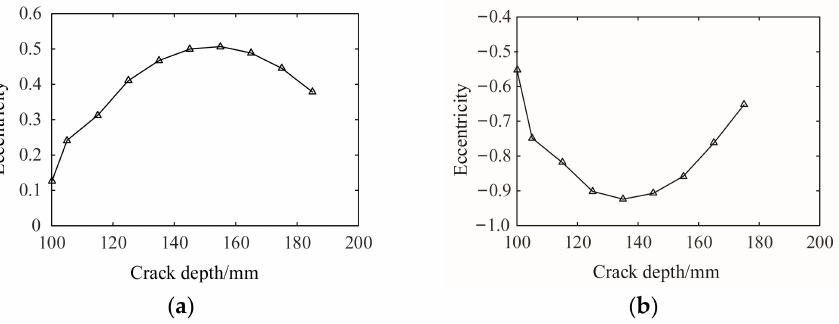
Figure 10. Relationship between the crack depth and eccentricity: ( a ) arch crown, ( b ) arch